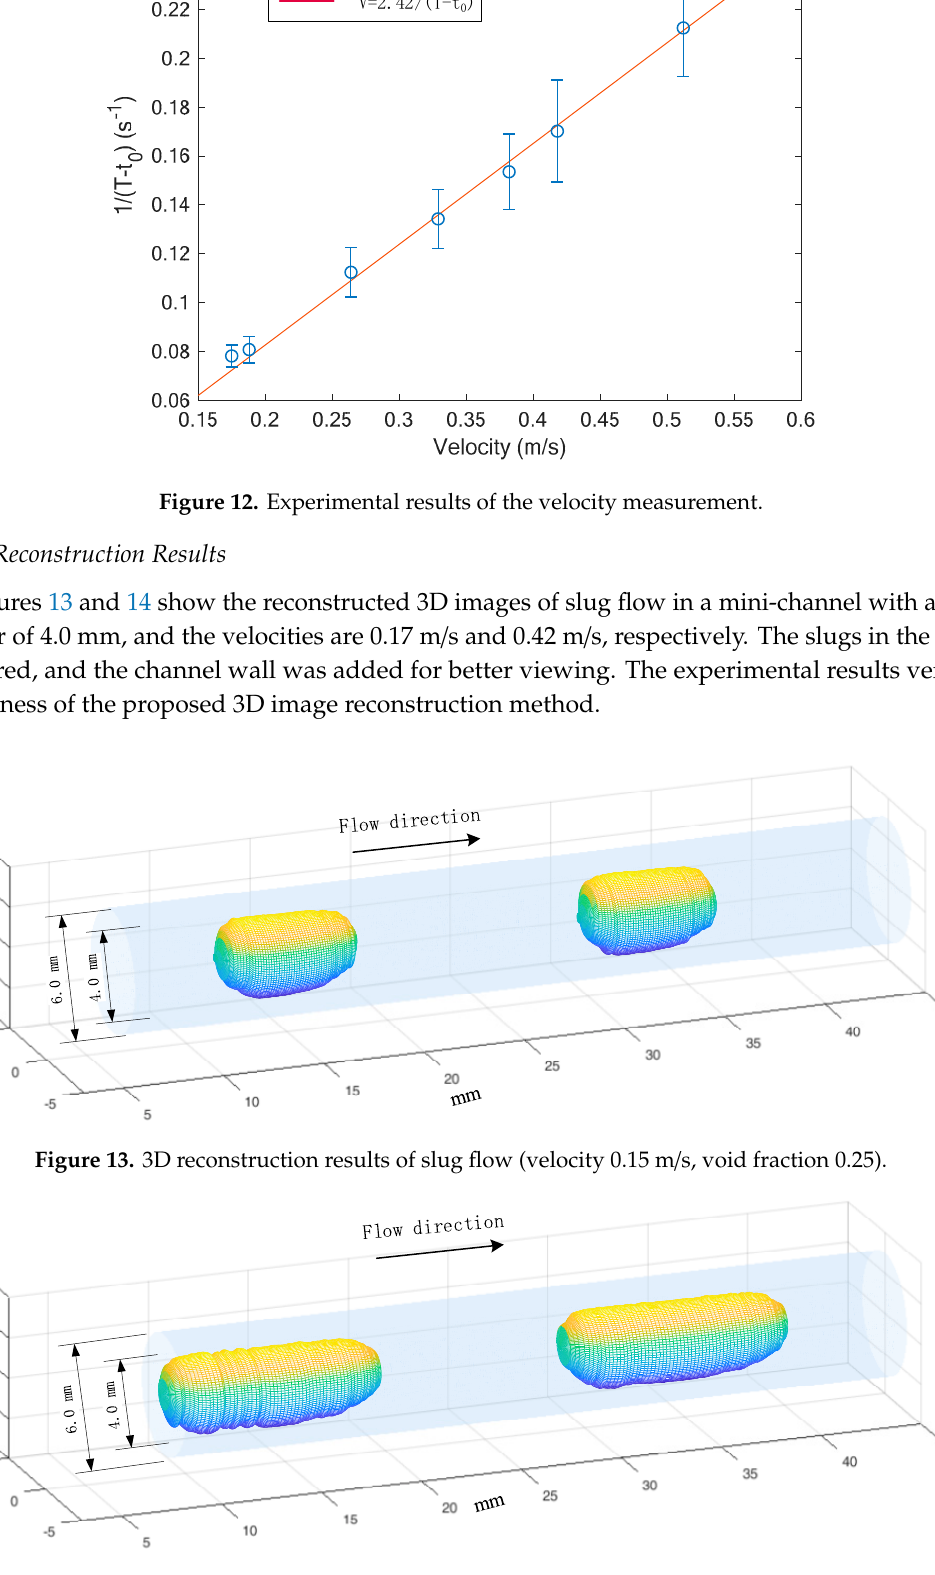
Figure 12. Experimental results of the velocity measurement.